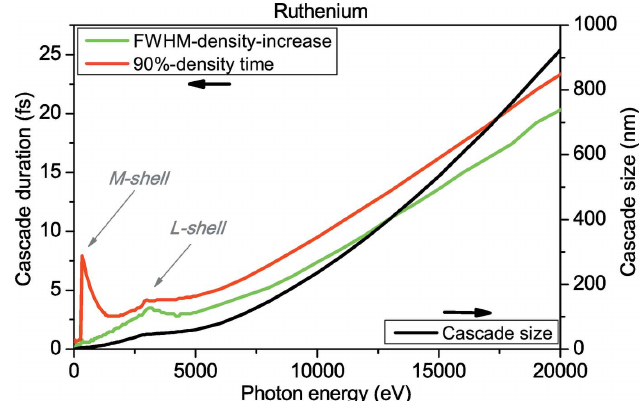
Figure 5 Left axis: photon-induced electron cascade duration in ruthenium defined in two ways: as the full width at half-maximum of the electron density derivative (green curve), and as the time instant where electron density reaches 90% of the total density (red curve). Right axis: photon-induced electron cascade size in ruthenium as a function of incident photon energy (black